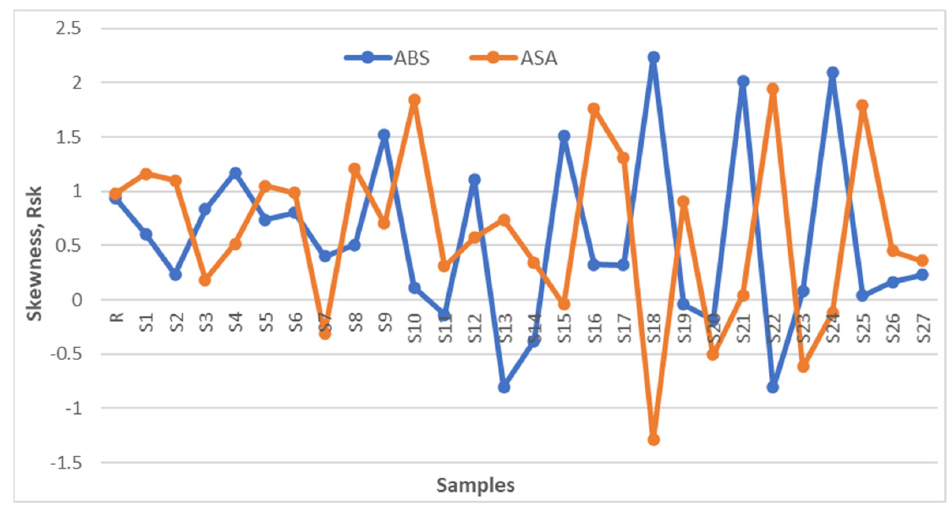
J. Compos. Sci. 2022 , 6 , x FOR PEER REVIEW Figure 4. Skewness plots.